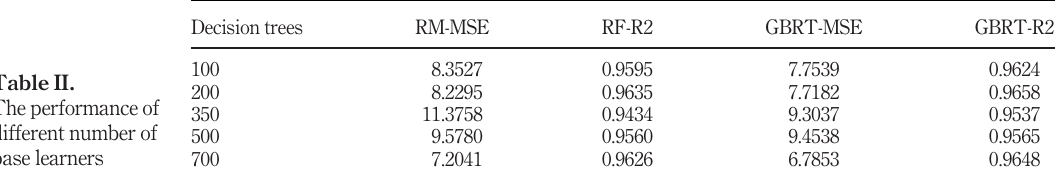
Figure 4. Modeling time of GBRT and RF